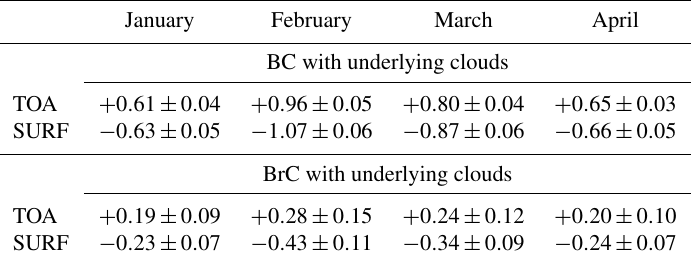
Table 2. Monthly mean area-weighted global-equivalent TOA and surface RF (in Wm − 2 ), for January to April 2020, for different scenarios of the unmeasured optical properties of the Australian fire plume (see definitions in Table 1), with underlying clouds modelled as surface with large R s reflectivity ( R s = 0 . 5).